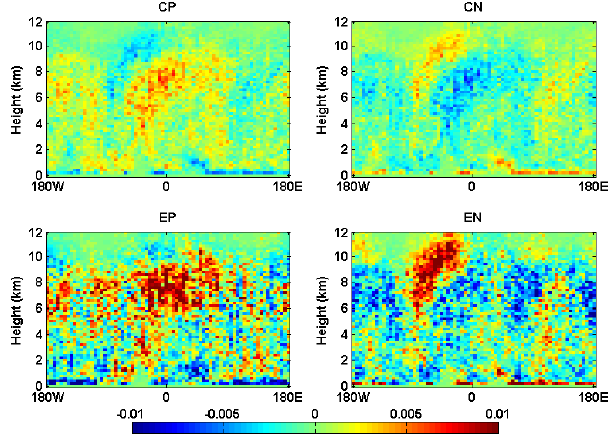
Fig. 4. The vertical distribution of cloud fraction anomalies derived Fig. 4: The vertical distribution of cloud fraction anomalies derived using AIRS data using AIRS data across 180 ◦ W–180 ◦ E (in 5 ◦ bins) averaged over across 180W-180E (in 5˚ bins) averaged over 67N-82N during various phases of the AO. 67–82 ◦ N during various phases of the AO. Anomalies enclosed by Anomalies enclosed by contours exceed at least one standard deviation. contours exceed at least one standard deviation.